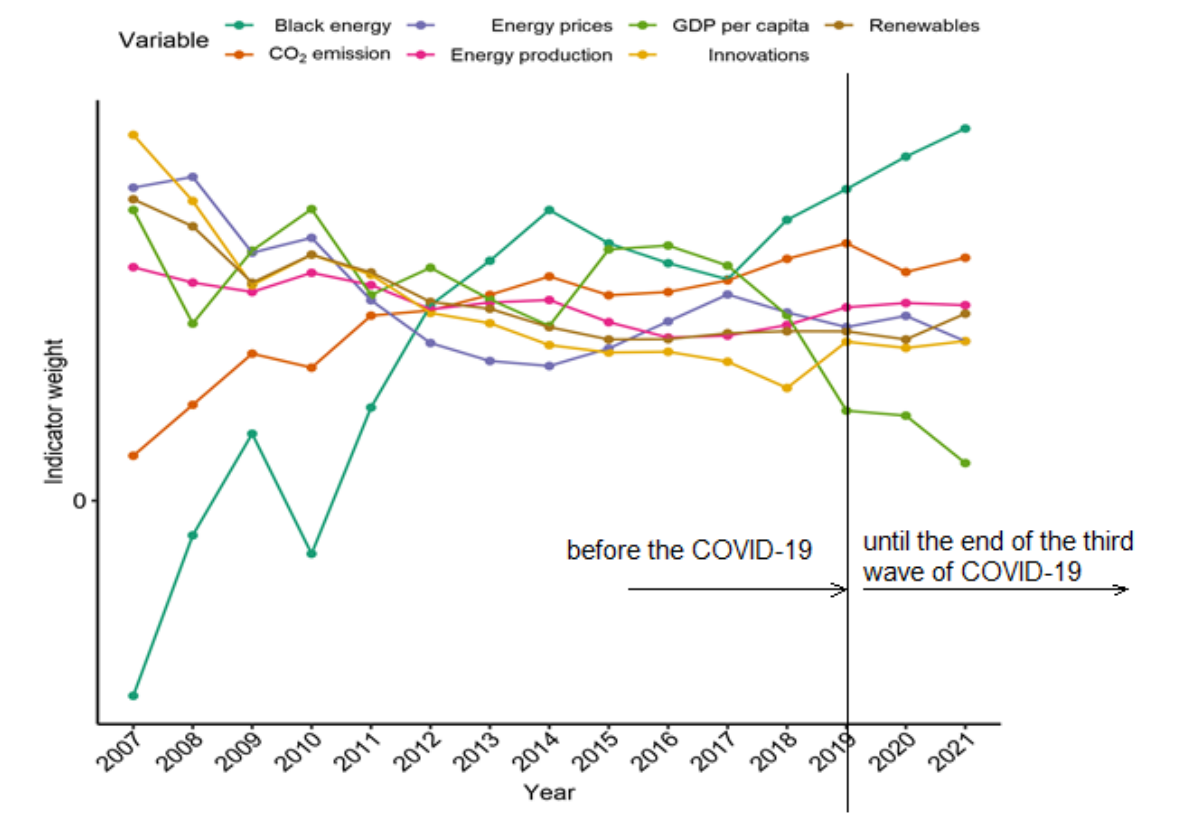
Figure 5. The variables’ weights for multi attribute value functions.